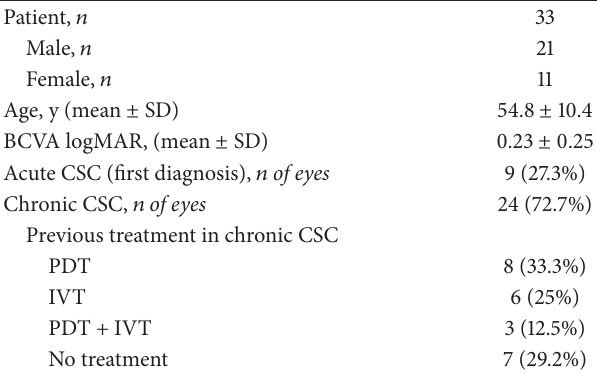
Table 2: Automatic segmented choriocapillaris OCTA features in CSC